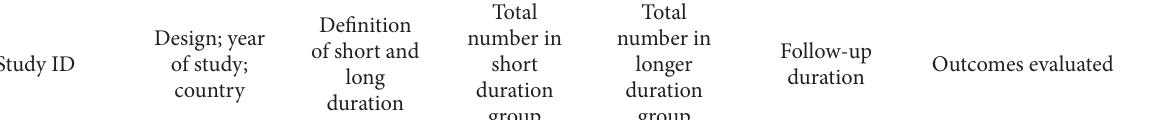
Table 1: Study design, duration of dual antiplatelet therapy, follow-up, and outcomes